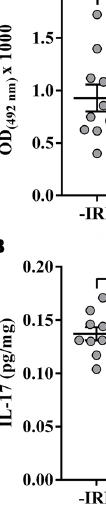
Figure 2. Influence of exposure to IR fibres on the level of CII-specific IgG antibodies in sera and the production of IL-17 in inflamed paws from CIA-affected rats. (A) Scatter plot indicates the level of anti-CII IgG antibodies (OD 492nm × 1000) in sera from CIA rats housed in cages with IR fibres bedding (+IRF rats) and with standard wooden shaving bedding (−IRF rats). Of note, rats were transferred to cages with IR fibre bedding five days before immunization. (B) Scatter plot shows IL-17 production level in the supernatants from hind paw tissue cultures (normalized to the paw weight) from +IRF and −IRF rats. Scatter plots were created using GraphPad Prism version 7.00 for Windows, GraphPad Software, La Jolla, California,USA (https ://www.graph pad.com). Results are expressed as mean ± SEM. n = 10 rats/group. * p ≤ 0.05 and ** p ≤